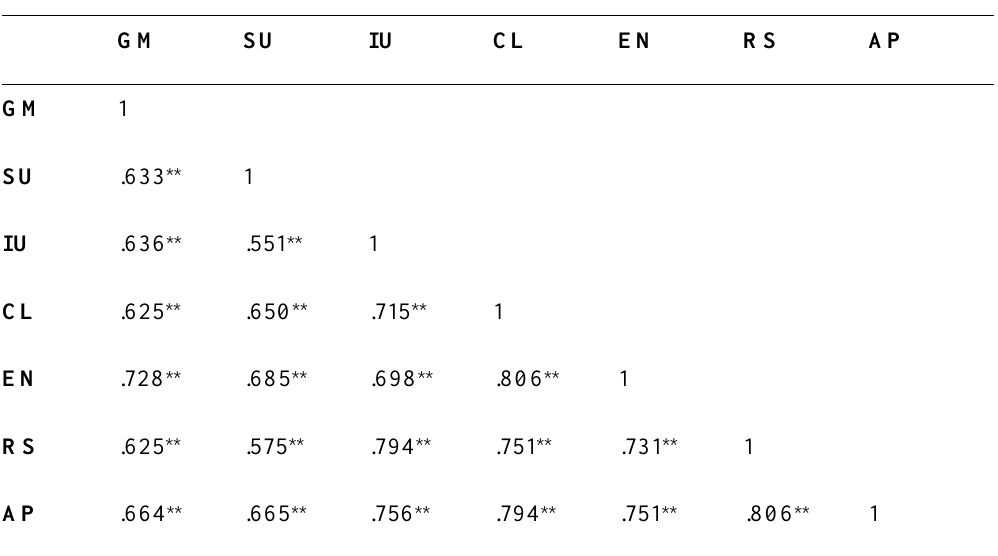
Descriptive statistics and correlation